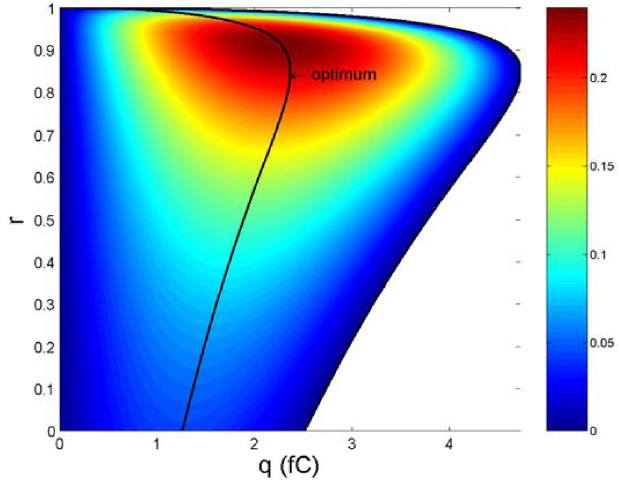
FIG. 3. (Color) Energy efficiency as a function of reflectivity and charge for (cid:21) (cid:1) 0 : 05 . The blank part is where (cid:15) < 0 , and the hard black line gives the maximum efficiency for a given reflectivity. The optimum case is chosen as indicated in the